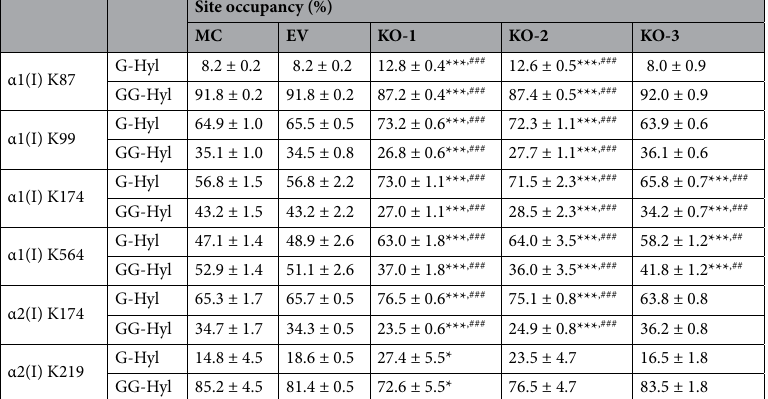
Table 5. Extent of two glycosylation forms of hydroxylysine in type I collagen isolated from MC and KO clone. Glycosylation of Hyl residues (%) represents the relative levels of G-Hyl, and GG-Hyl (G-Hyl + GG-Hyl = 100%). Values represent mean ± S.D. (n = 3) of triplicate analysis for each group. Statistical differences were determined by Kruskal–Wallis one-way analysis of variance and means comparison with the controls by Dunnett’s method. Hyl hydroxylysine, G- galactosyl-, GG- glucosylgalactosyl-, MC MC3T3-E1, EV empty vector, KO knock-out. *p < 0.01 and ***p < 0.001 between MC and KO; ## p < 0.01 and ### p < 0.001 between EV and KO,